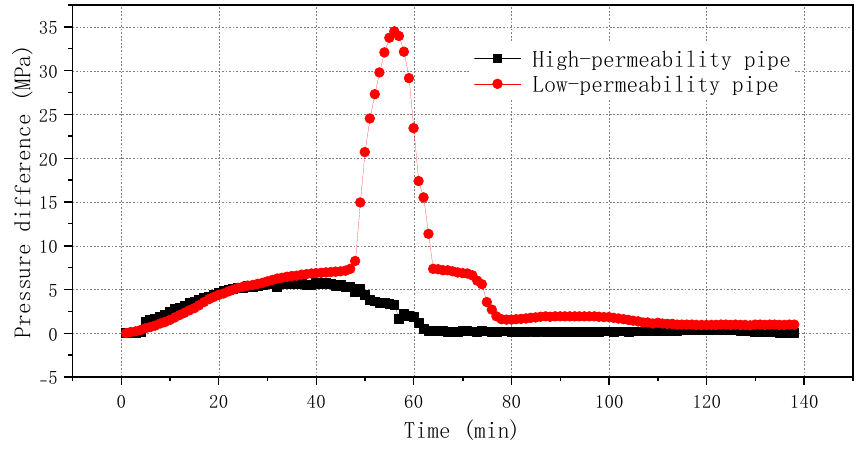
Figure 4. Displacement pressure of two different permeability sand pack.